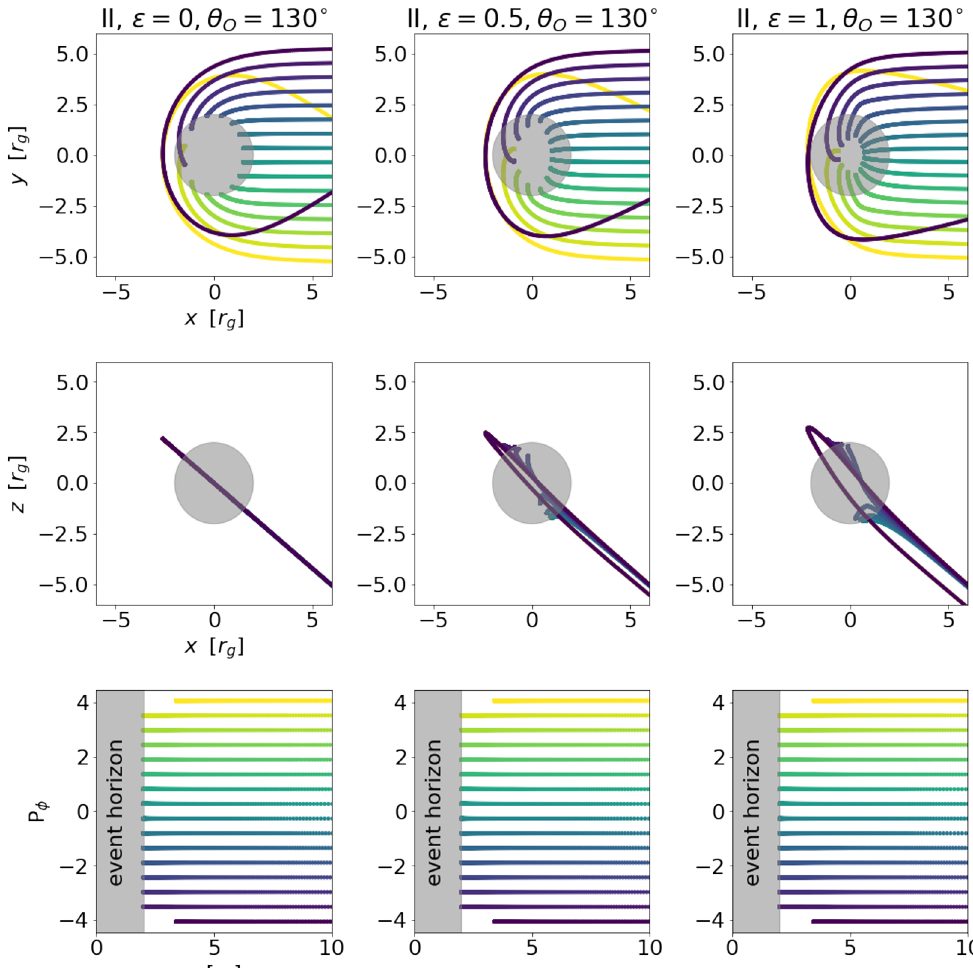
Figure 5 . Some examples of Light-rays and their properties in the CLI metric with soft hair II given in (4.9) with E = 0 (first column, Schwarzschild metric), 0 . 5 (second column) and 1 . 0 (third column). The first row shows the face-on view of the geodesics. The second row shows the edge-on view and therefore highlights the features caused by non-vanishing g rθ . The third row shows the constancy of angular momentum L z along the light-rays as a numerical consistency check. The shaded regions indicate the black hole’s event